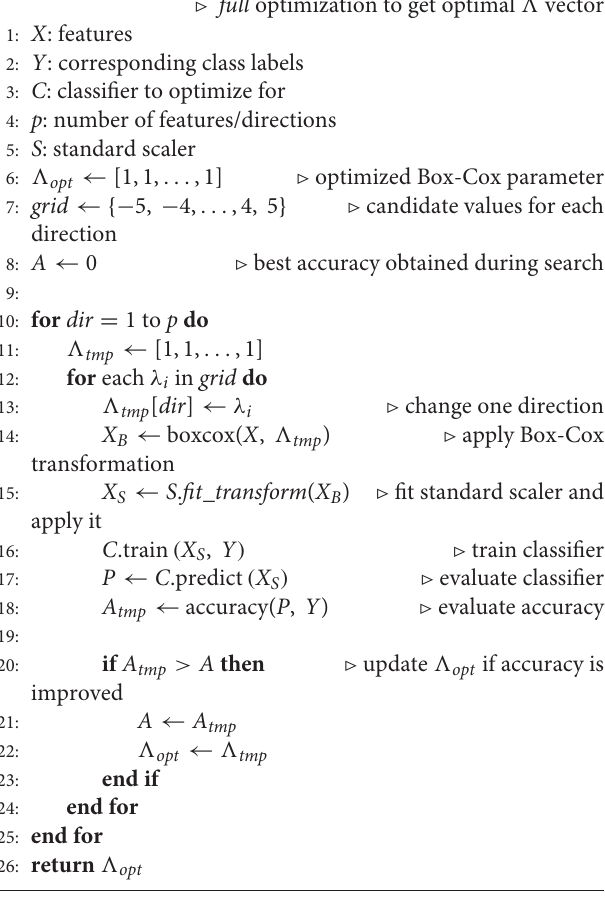
Algorithm 8 : Diagonal grid search( X , Y , C ) ⊲ full optimization to get optimal 3 vector